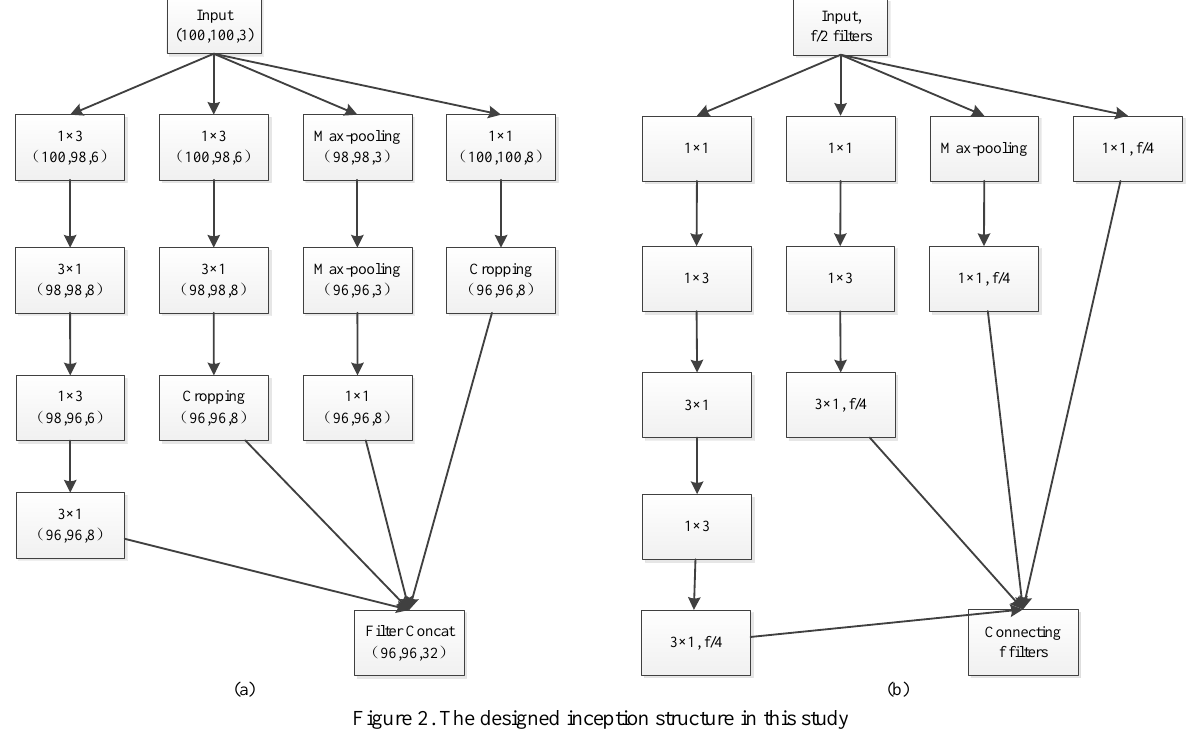
Figure 2. The designed inception structure in this study